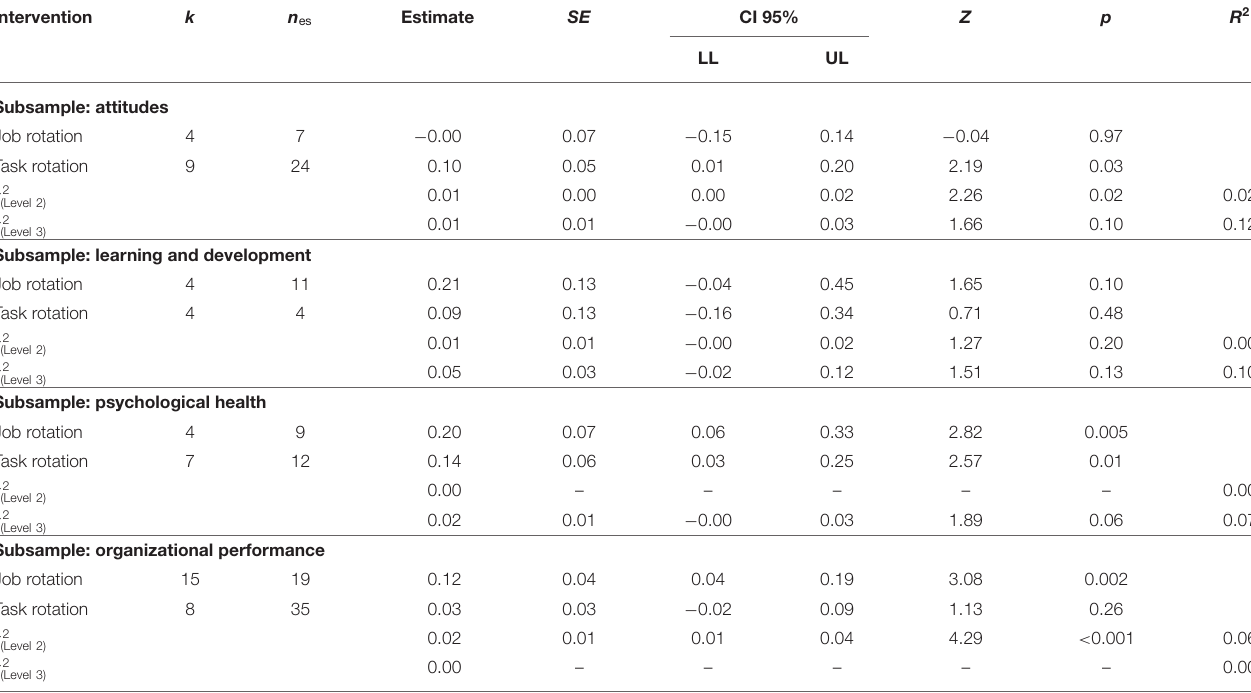
TABLE 3 | Results of moderated meta-analysis that compares job rotation with task rotation for different outcome categories. Intervention